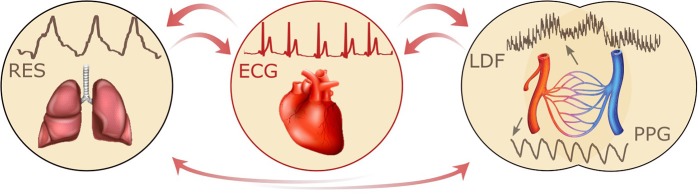
Schematic representation of the interactions between respiratory, cardiac and vascular activity, together with the corresponding recordings: respiratory effort signal (RES), electrocardiogram (ECG), laser Doppler flowmetry (LDF) and pulse plethysmography (PPG). In the resting state, the concentration of red blood cells can be considered constant, and so a Doppler shift in the velocity signal provides a measure of microvascular flow. In contrast, the finger PPG provides a measure of changes in arterial volume proportional to changes in arterial blood pressure.